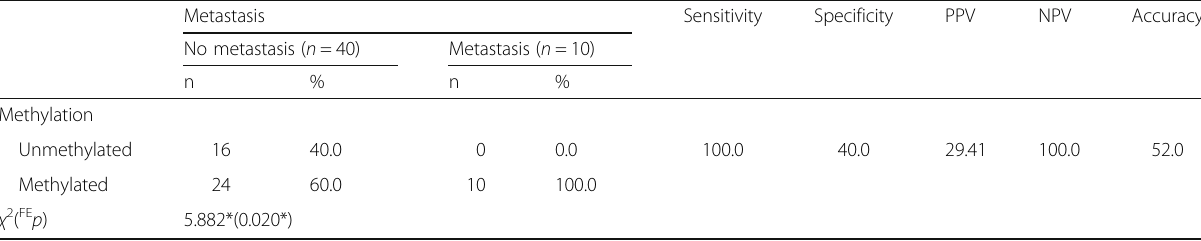
Table 3 Diagnostic performance of methylation in relation to metastasis